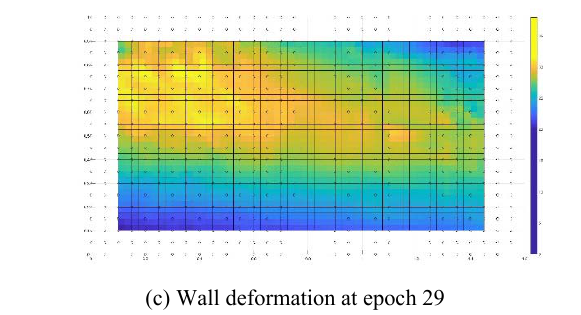
Figure 5. Filtering and interpolation